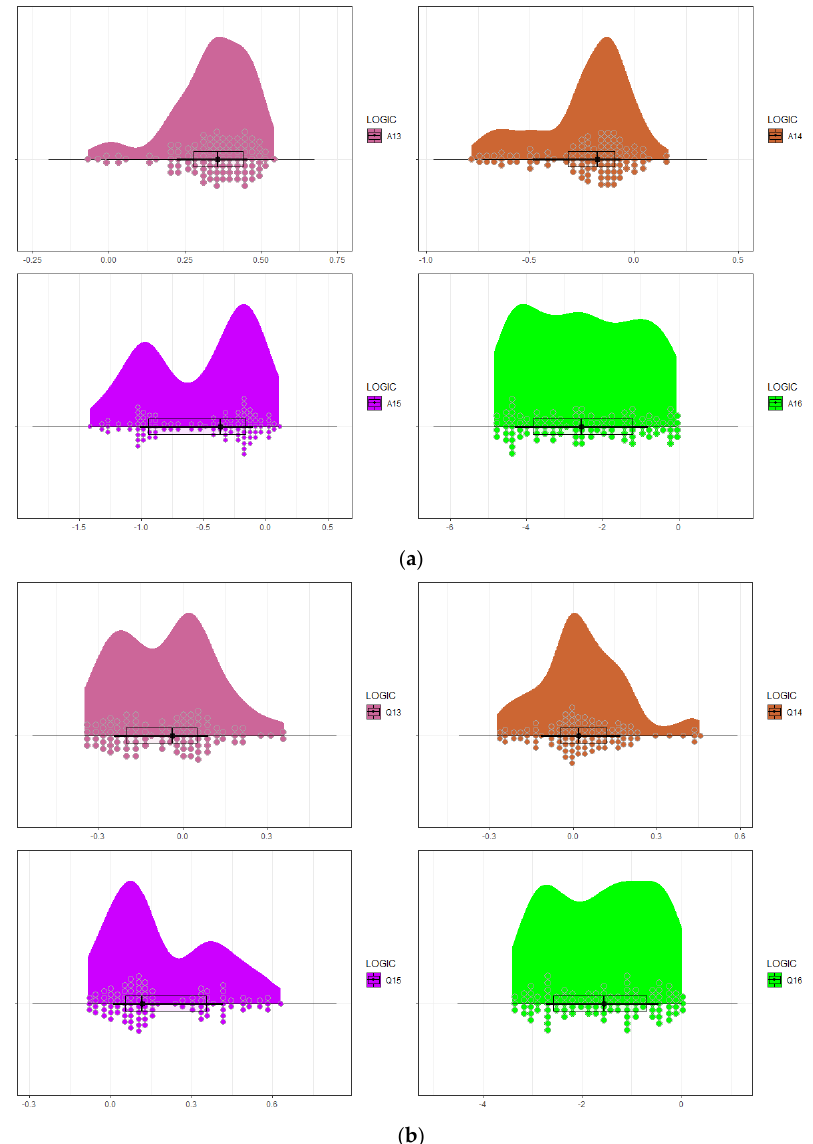
Figure 17. The Raincloud Plot analysis for ( a ) δ 1 2 SAT ρ , ( b ) δ 2 2 SAT ρ synaptic weight means when 0.9 Y = .